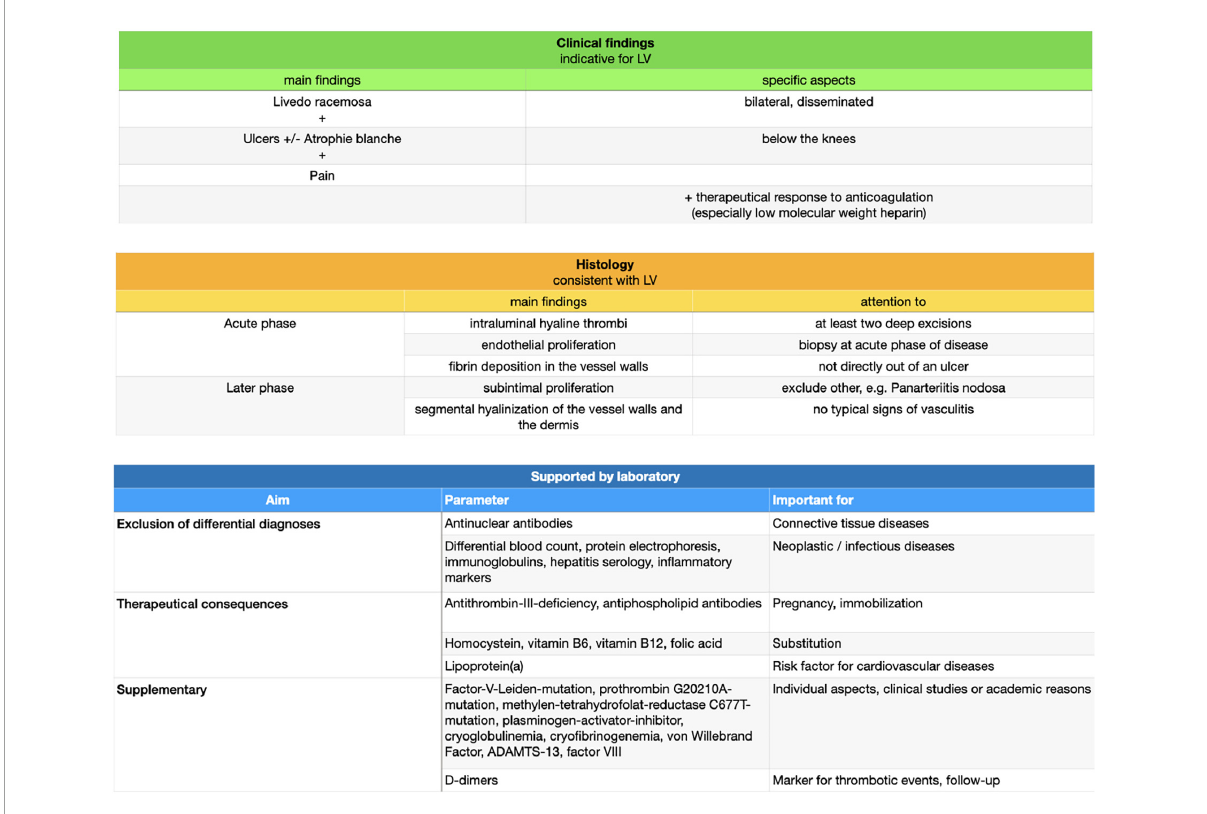
FIGURE8 Diagnostical